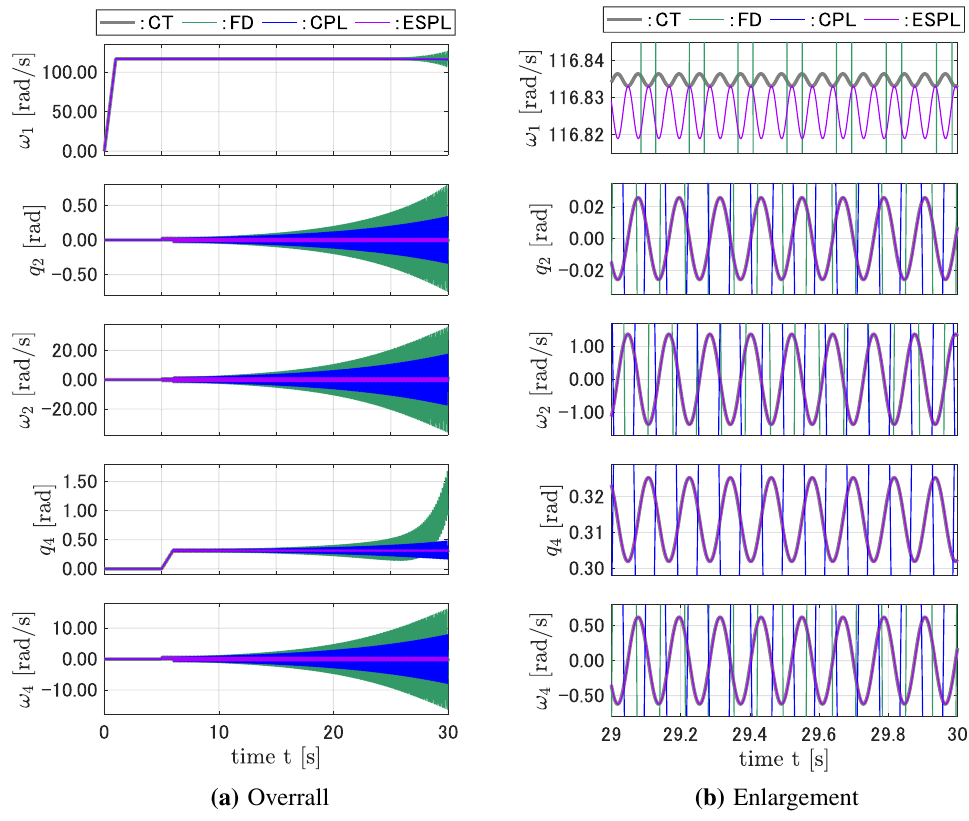
Figure 4. Responses of the CT, FD, CPL, and ESPL models for case